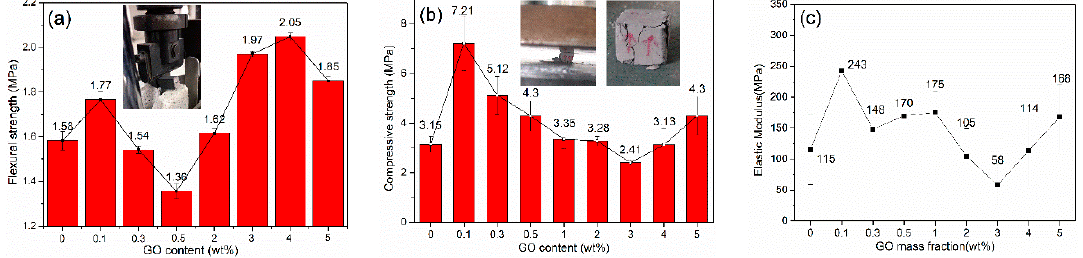
Figure 9. Mechanical properties of CGCB: ( a ) flexural strength, ( b ) compressive strength and ( c ) elastic modulus.